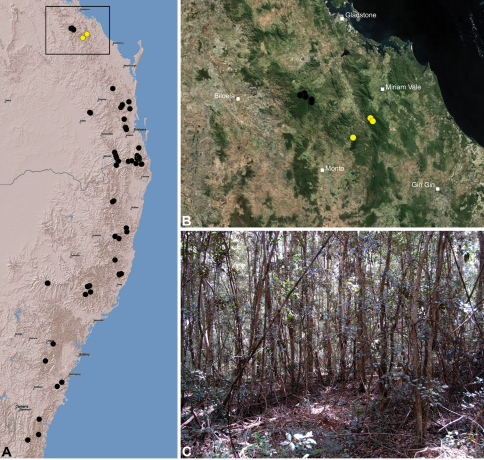
Austrarchaea aleenae sp. n., distribution and habitat: A, topographic map showing the known distribution of Archaeidae in south-eastern Queensland and eastern New South Wales, with collection localities for A. aleenae highlighted in yellow; B, satellite image showing detail of inset (A); C, subtropical vine rainforest at the type locality – Bulburin Forest Road, Bulburin National Park, Queensland (October 2010). Image (C) by A. Rix, used with permission.